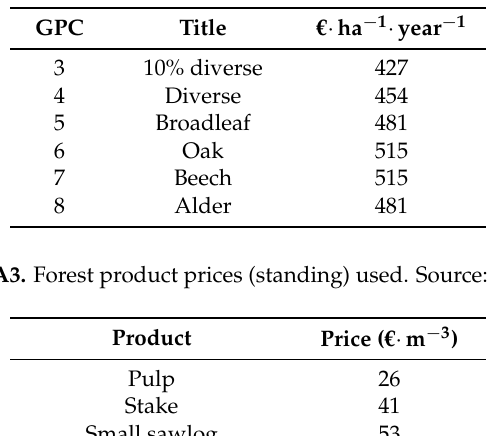
Table A2. Grant premium categories (GPC) and annual premiums in 2012. Source: Forest Service [52].